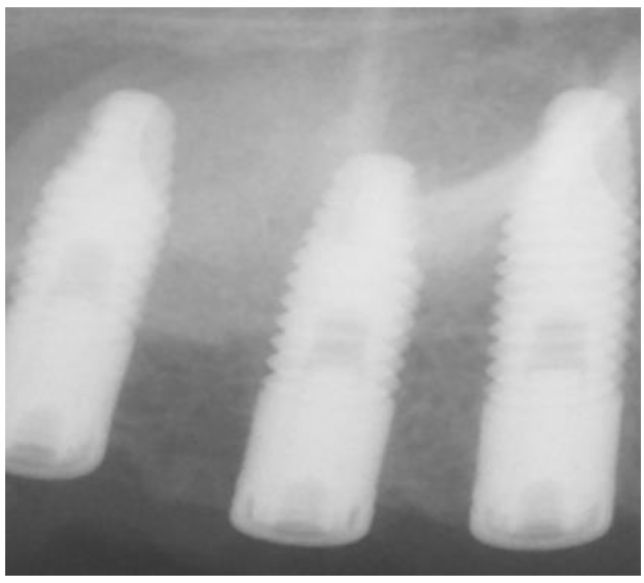
Figure 3. X-ray after installing the